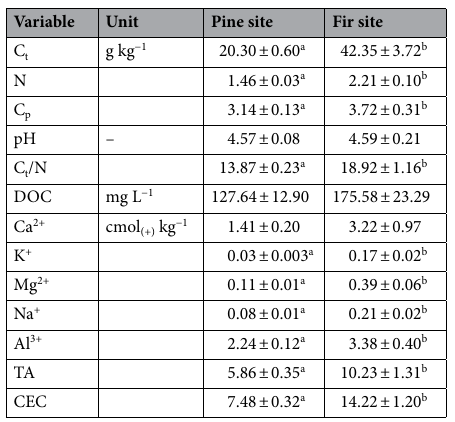
Table 2. Chemical properties (mean values with standard error) of investigated soils. Different superscript letters indicate significant differences between sites (Kolmogorov–Smirnov test), p < 0.05. C t total carbon, N total nitrogen, DOC dissolved organic carbon, C p pyrophosphate extractable carbon, TA total acidity, CEC cation exchange capacity.